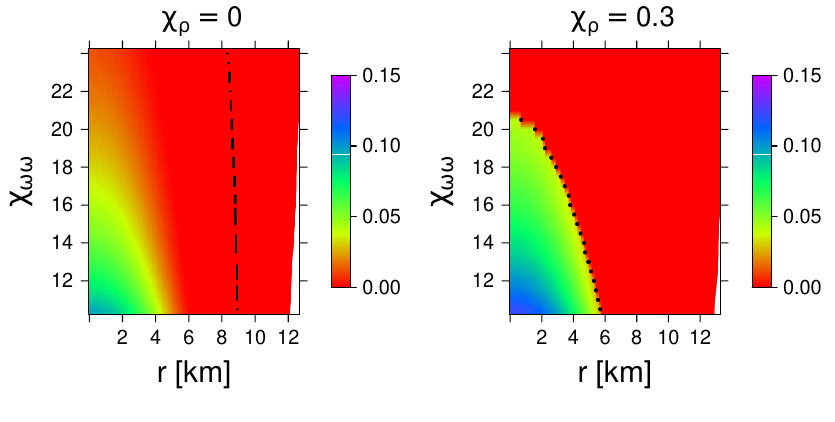
Figure 4. Strangeness profile for a 1 . 9 M (cid:3) hybrid star as a function χ ωω for χ ρ = 0 (left) and χ ρ = 0 . 3